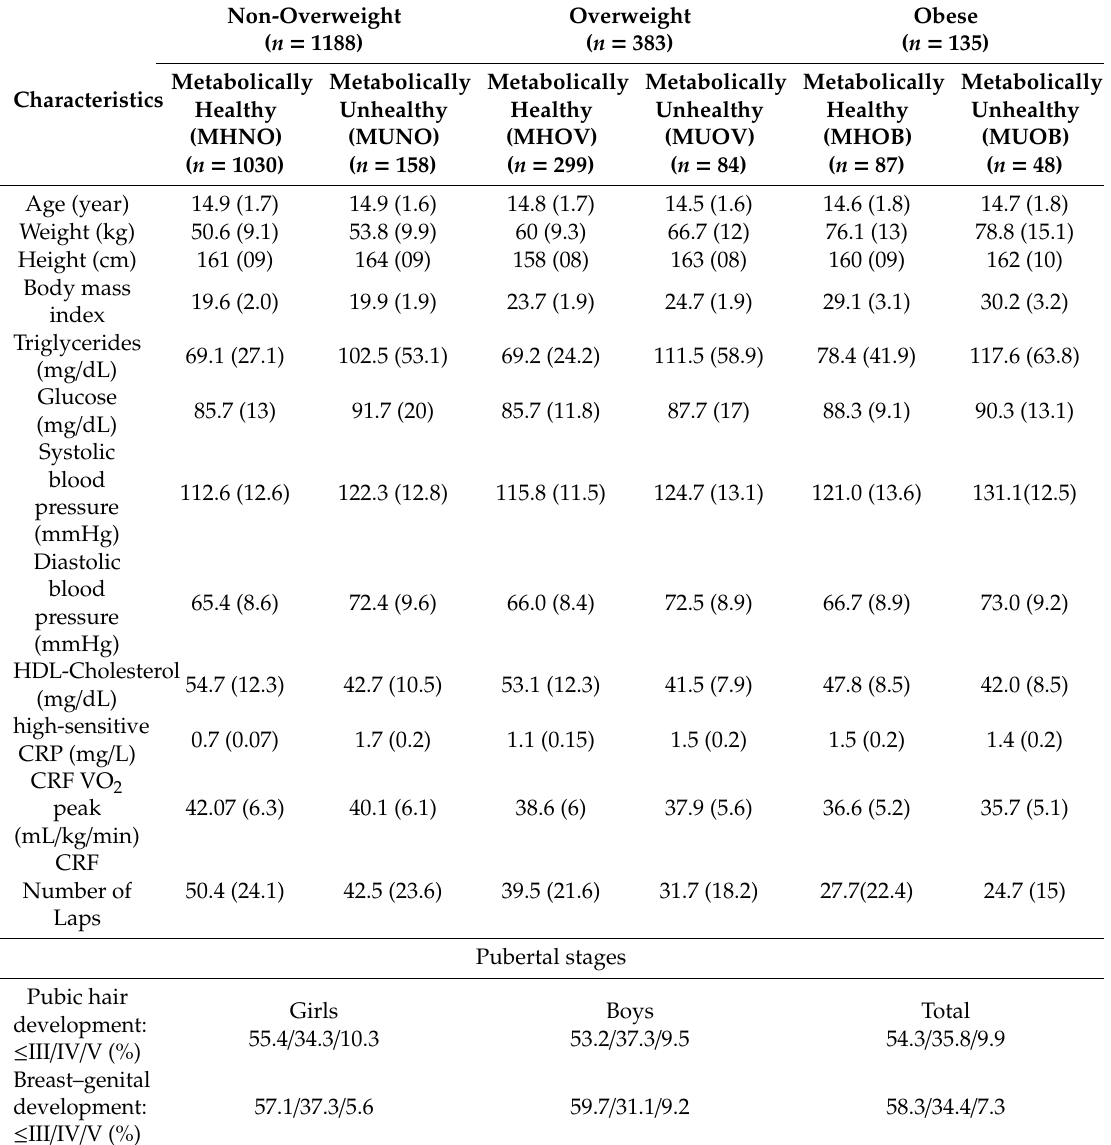
Table 1. Participants’ characteristics, according to the metabolic health